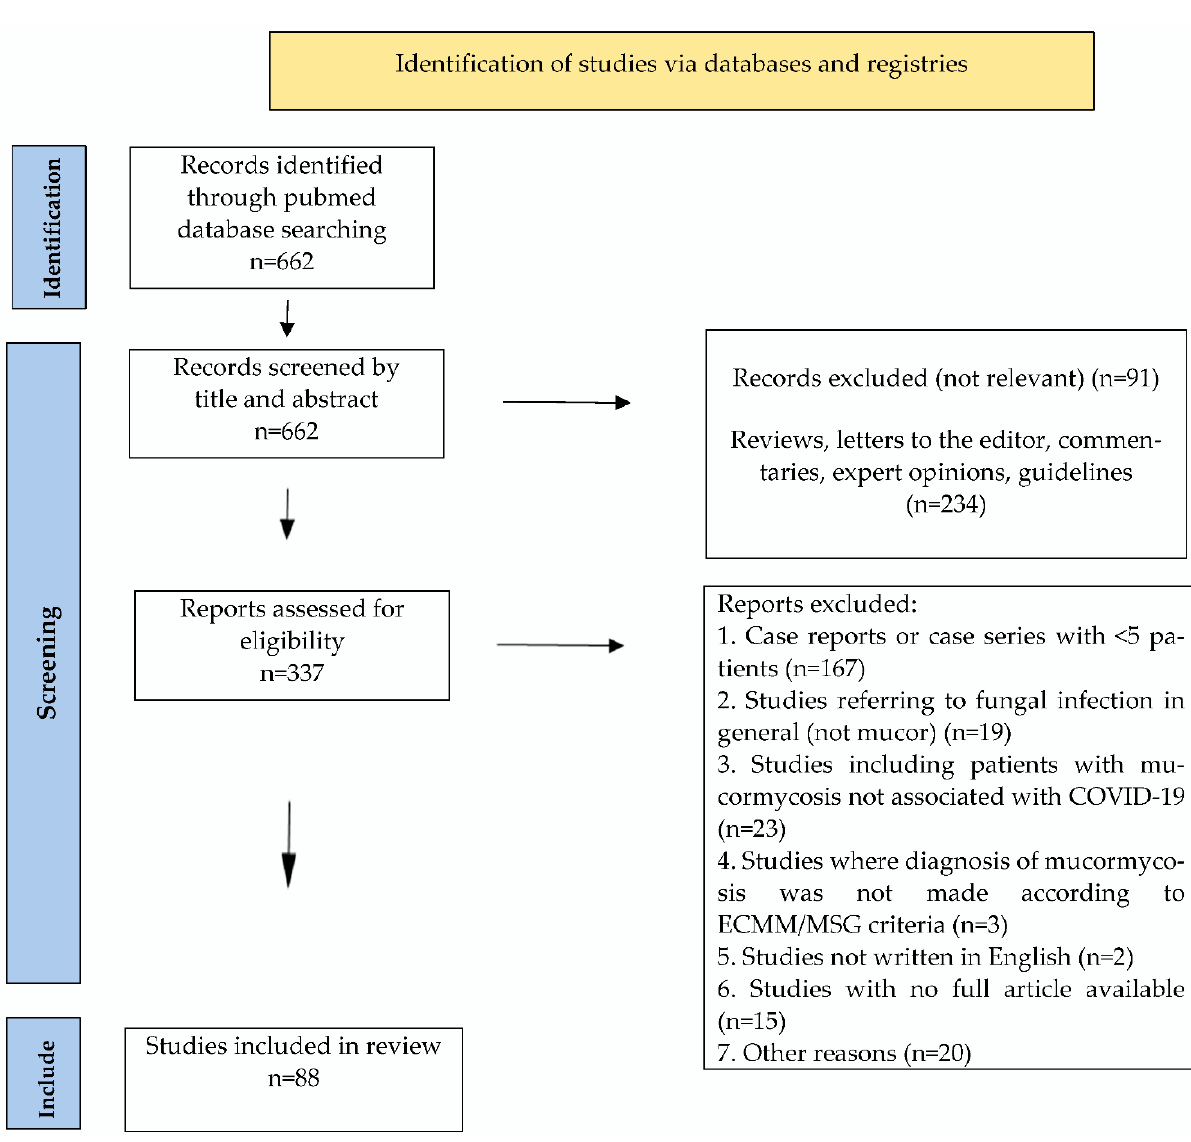
Figure 1. PRISMA Flowchart of published studies related to COVID-19 associated mucormycosis.